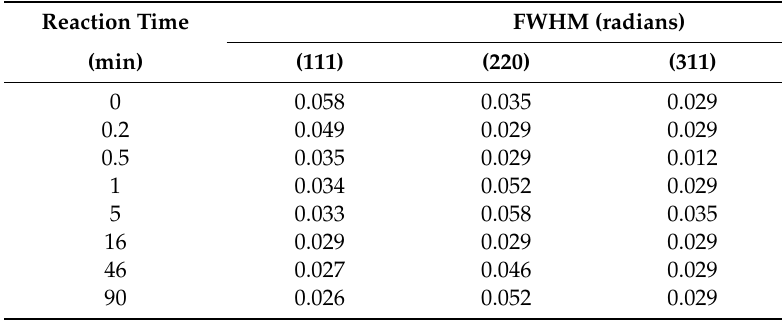
Table 2. FWHM values of the XRD di ff raction peaks of Mn-doped CdSe QDs corresponding to the (111), (220), and (311)